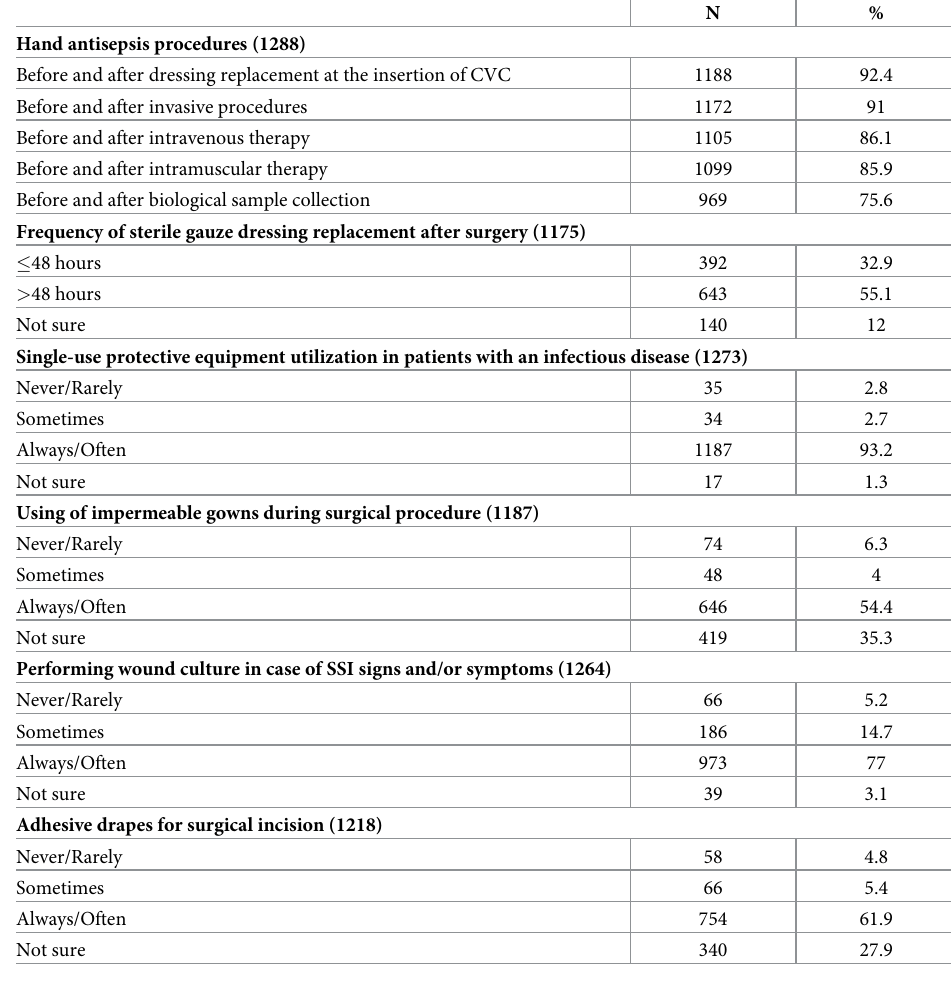
Table 2. Self-reported evidence-based practices on SSI